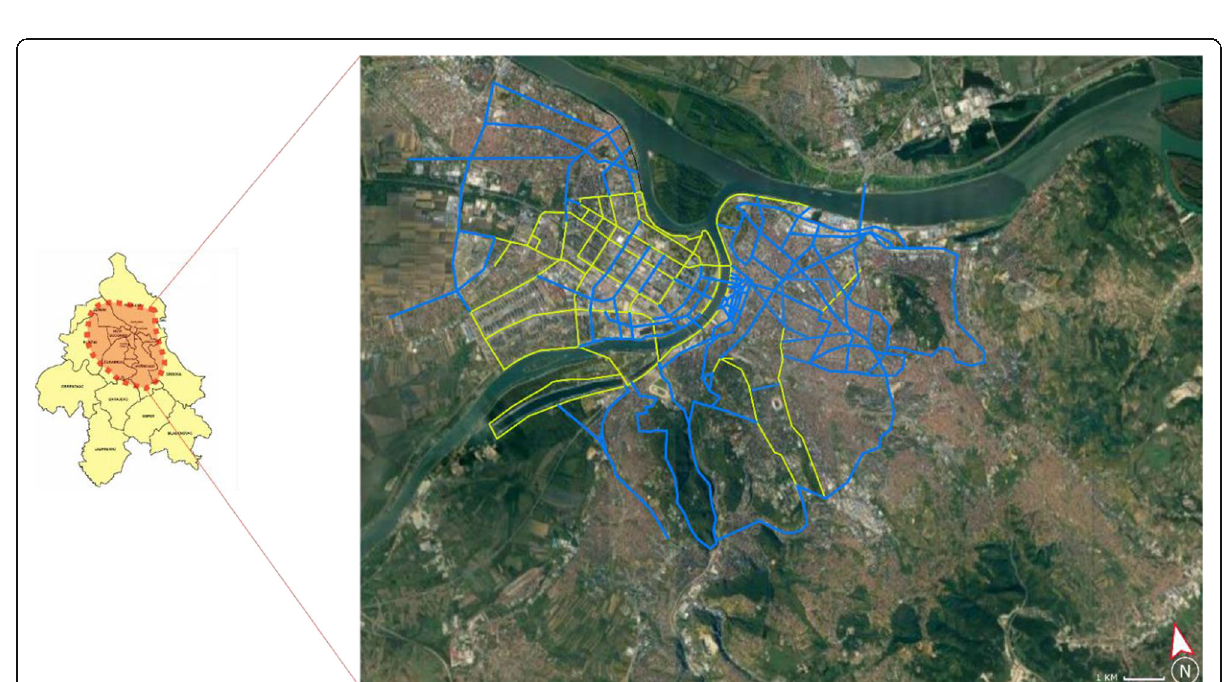
Fig. 4 The network of bicycle lanes in